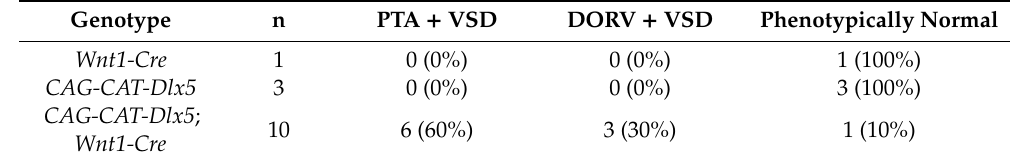
Table 1. Outflow tract (OFT) defects observed in Dlx5 neural crest cell (NCC) oe mutants.